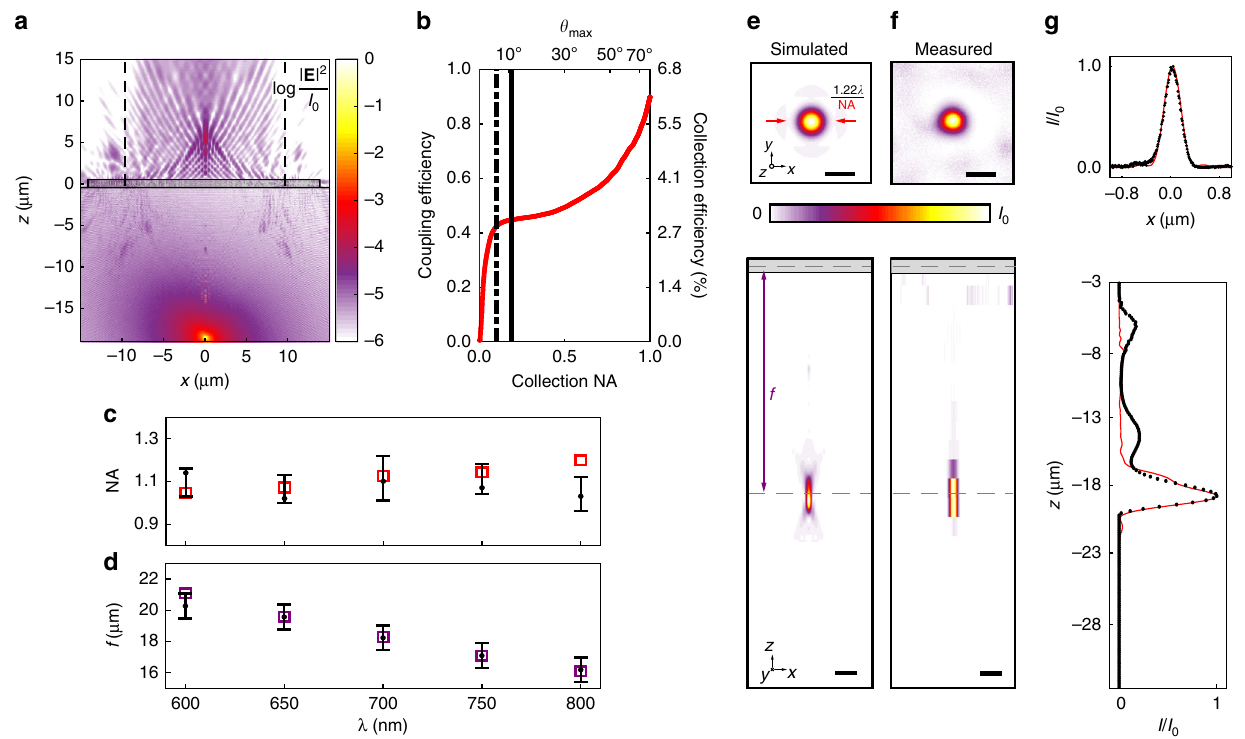
Fig. 3 Metalens performance. a Simulated steady-state fi eld intensity produced by the two optical dipoles of an NV center (with [111] orientation) placed at the metalens focus at λ = 700 nm. The position of the metalens is indicated by the gray box. Dashed black lines indicate the 19.3- μ m effective aperture of the metalens. b Coupling ef fi ciency and overall collection ef fi ciency as a function of the acceptance angle of the collection optics placed after the metalens, calculated from the simulations shown in a . The dashed and solid lines indicate NA values 0.1 and 0.19, corresponding to the NA of the optical fi ber and collimating lens used in the measurements, respectively. c Measurement (black points) and simulation (open red squares) of the metalens NA as a function of wavelength. Error bars represent the uncertainty in the objective NA, as described in the Methods section. d Measured (black points) and simulated (open purple squares) effective focal length. Error bars represent the uncertainty in estimating the positions of the focal spot and diamond surface. e , f Transverse ( x – y , top) and axial ( x – z , bottom) cross-sections of the metalens focal spot at λ = 700 nm: e simulated using a 3D fi nite-difference time-domain (FDTD) method, and f measured using a confocal scanning optical microscope with the microscope ’ s point-spread function deconvolved. Gray boxes and dashed lines in axial cross-sections indicate the thickness of the metalens pillars and focus position, respectively. Scale bars denote 500 nm in transverse plots and 1 μ m in axial cross-sections. g x (top) and z (bottom) line scans of the simulated (solid red curves) and measured (points) metalens focus at λ = 700